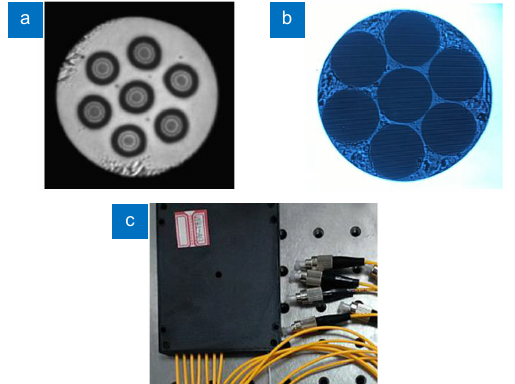
Fig. 1 | ( a ) Cross-sectional view of the fabricated 7-core fiber. ( b ) Endview of the 7-SMF bundle. ( c ) The packaged MCF fan-in/out coupler. Figure reproduced from ref. 22 , Optical Society of America.